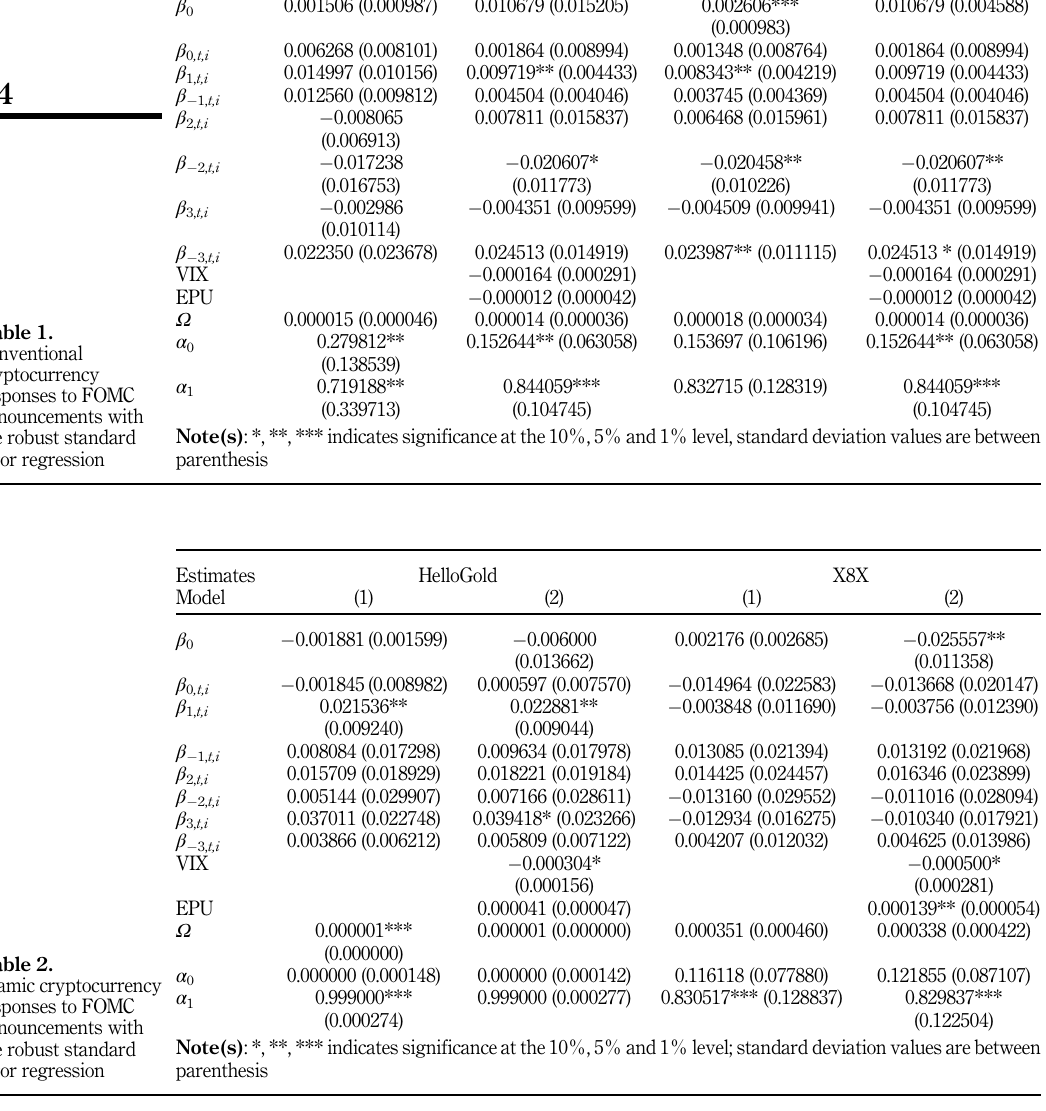
Table 2. Islamic cryptocurrency responses to FOMC announcements with the robust standard error